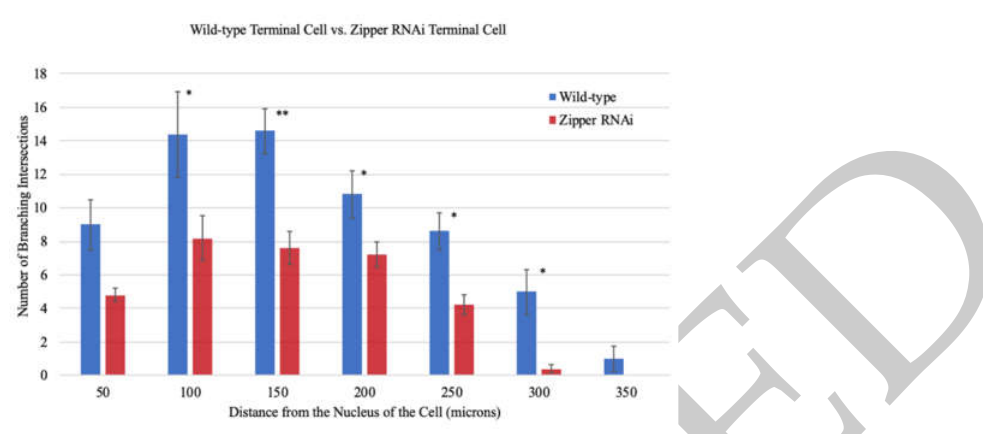
Figure 5. Sholl analysis for branching morphogenesis of controls and mutants. Sholl analysis demonstrated defective branching of RNAi mutants compared to wild-type with n = 40 for controls and n = 40 for mutants. The sample size represents the number of fruit flies that were used in the study. As only one terminal cell was observed for each fruit fly, the sample size also indicates the number of cells. Each fruit fly had a different and independent number of branches. Each of the branch measurements has been accounted for and included in the comparison between wild-types and RNAi mutants. Thus, this figure compares the controls and the mutants in their entireties at each distance from 0 µ m to 350 µ m in 50 µ m intervals. The error bars show ± Standard Error of the Mean (SEM). Single asterisks (*) indicate p < 0.05, double asterisks (**) indicate p < 0.01, and no asterisk indicates no statistically significant difference in the pair of results when performing an equal/unequal variance independent two-tailed T-test. Whether to use an equal or unequal variance T-test was decided using a F-test, where p < 0.05 indicated unequal variance and p > 0.05 indicated equal variance. This process of checking for variance made sure to account for individual-to-individual organism variability for each incremental measurement.